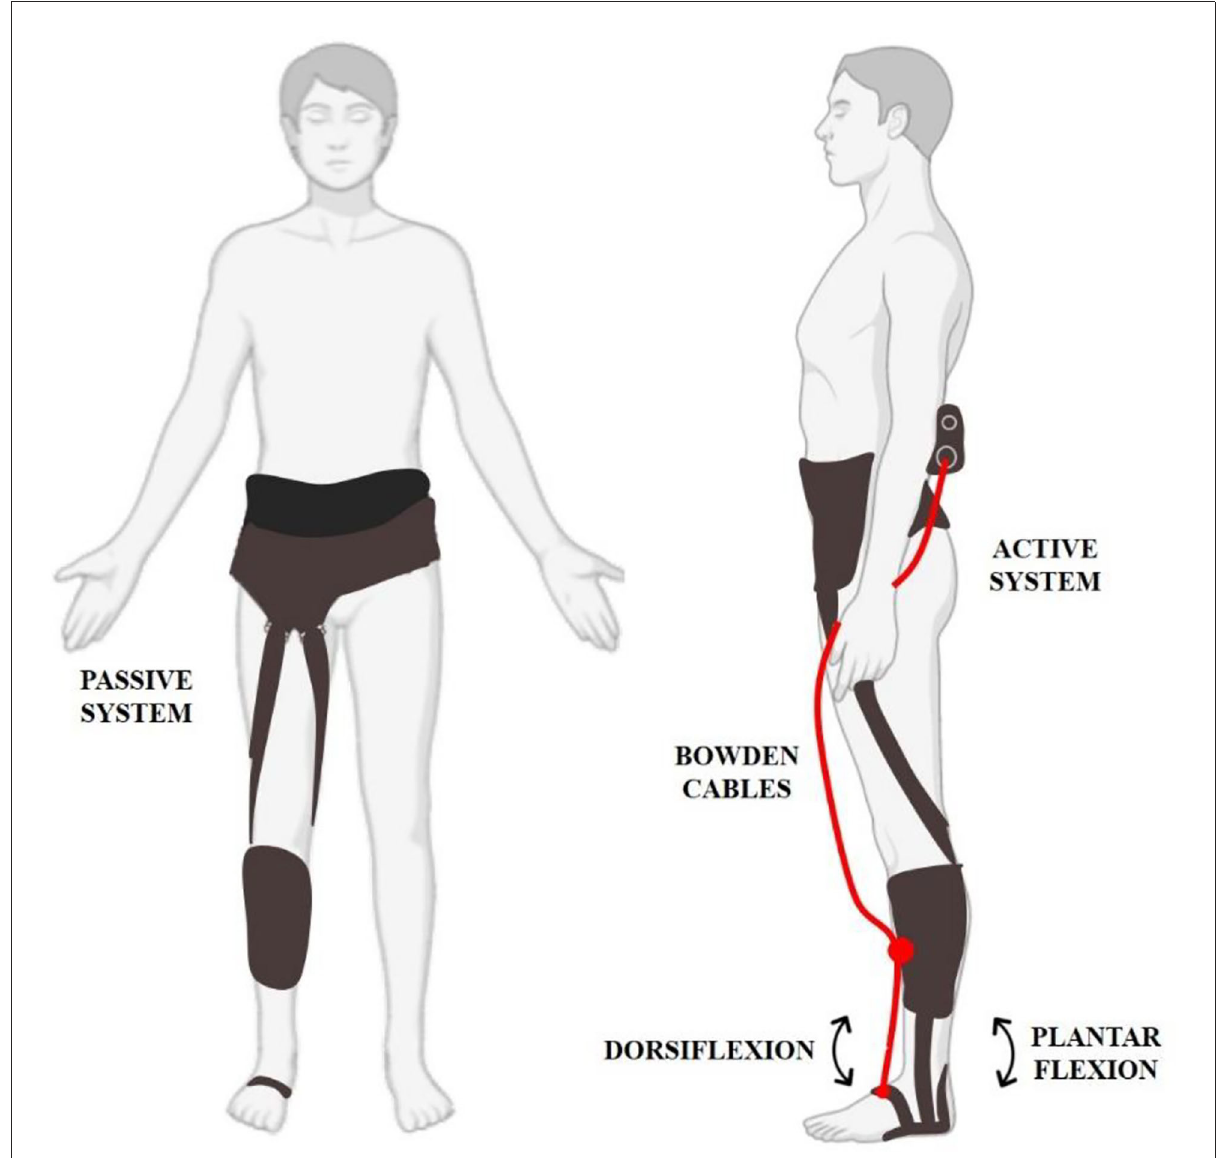
FIGURE2 The G-Exos is a hybrid wearable exoskeleton composed of a passive system that uses the natural gait biomechanics to promote dorsiflexion assistance and ankle eversion/inversion through tensioned elastic bands. The active system uses an electromechanical system for greater assistance in ankle dorsiflexion movement. The hybrid system combines both systems, and allows the device to be configured according to the user’s